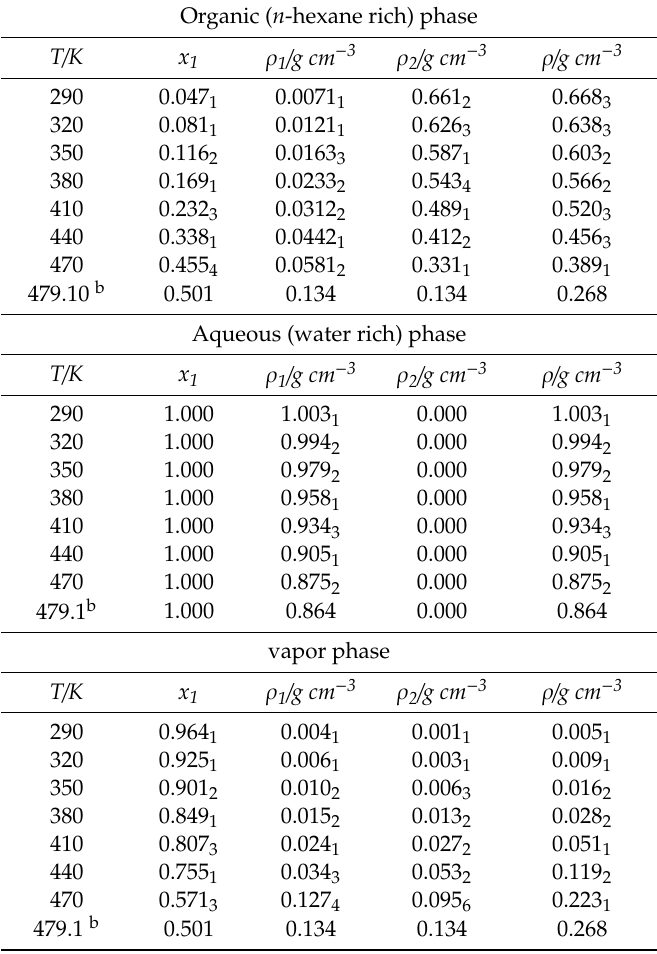
Table 3. Mass bulk densities and mole fractions results from Molecular Dynamics for water (1) + n -hexane (2) mixture along three-phase equilibrium a